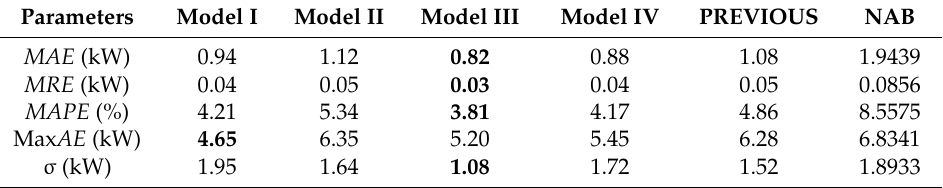
Table 20. Results obtained by neural network and NAB models over Test E, for a PH of 1 h. Parameters